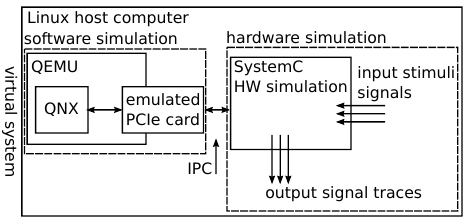
Figure 2: Virtual control